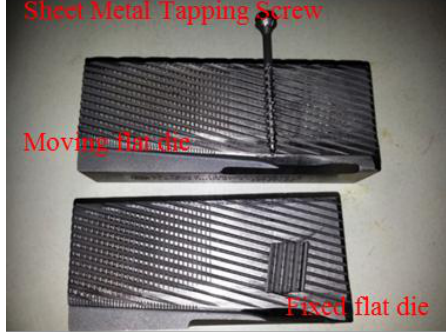
Figure 1. Cone bolt (CB) thread and screw thread plate.